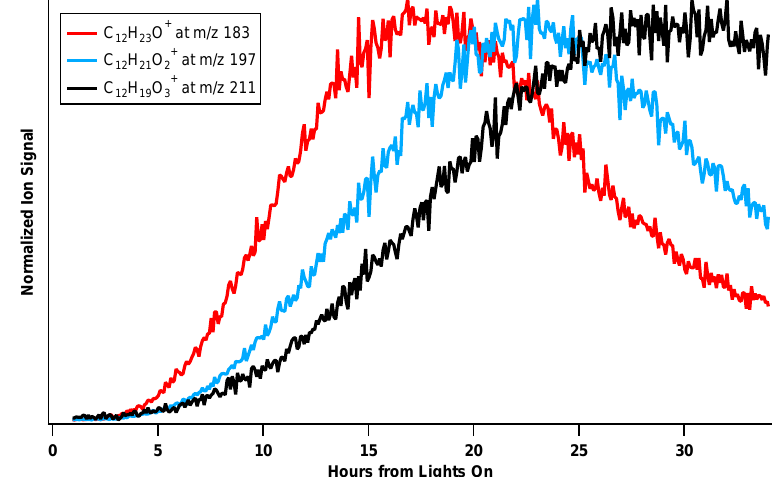
Fig. 5. C 12 backbone ions with varying contributions of oxygen have distinct time trends over the duration of the experiment.